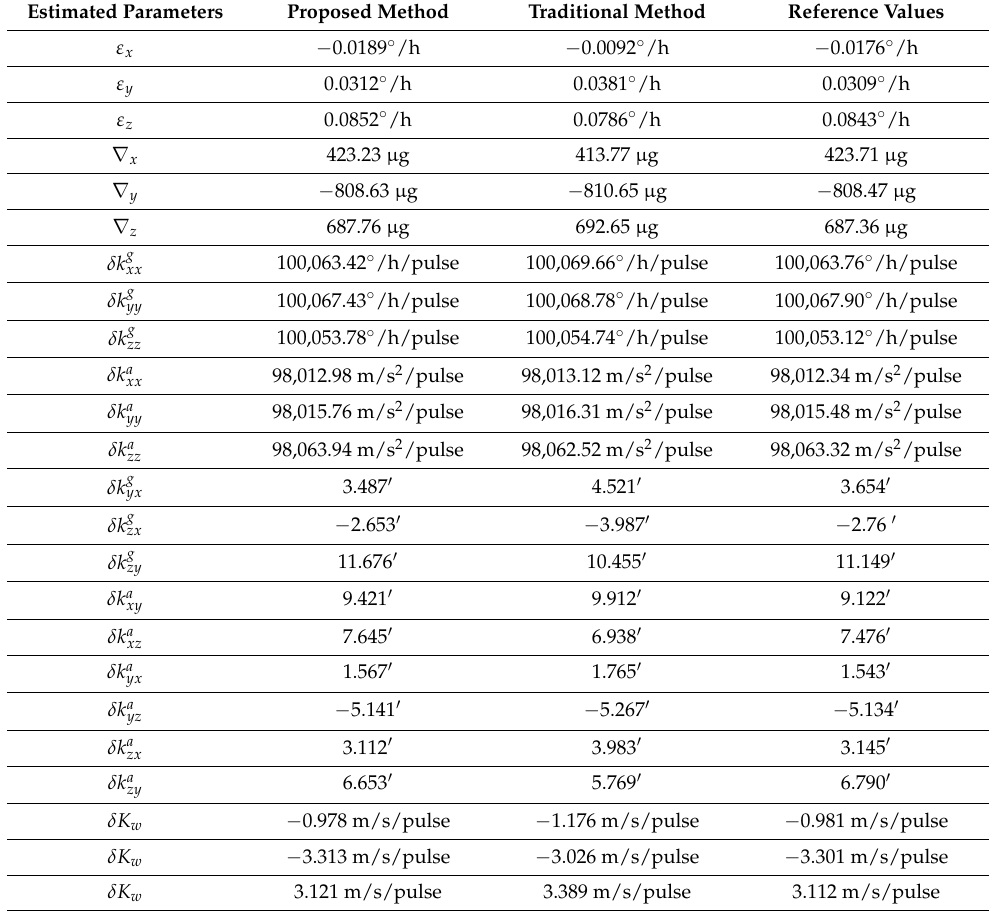
Table 2. Estimation results of different